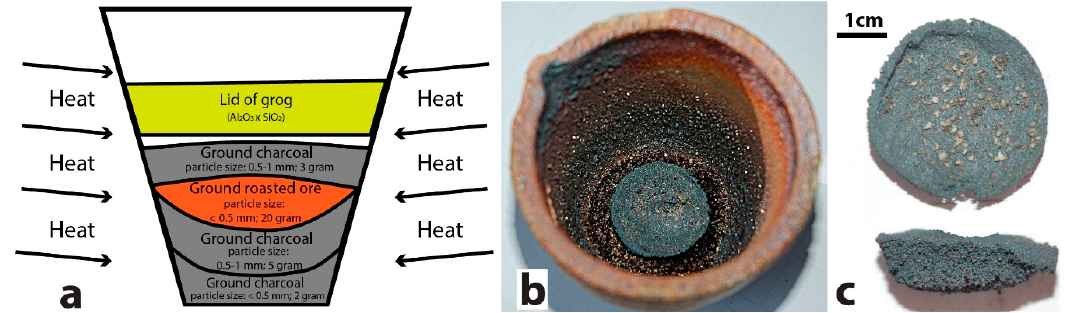
Figure 2. Visualization of crucible setup and final smelting product: ( a ) Schematic representation of the ore-charcoal layout inside the crucible; ( b ) typical appearance of the final smelting product (bloom) after completion of the experiment; ( c ) bloom: Top and lateral view (sample Negev-1).